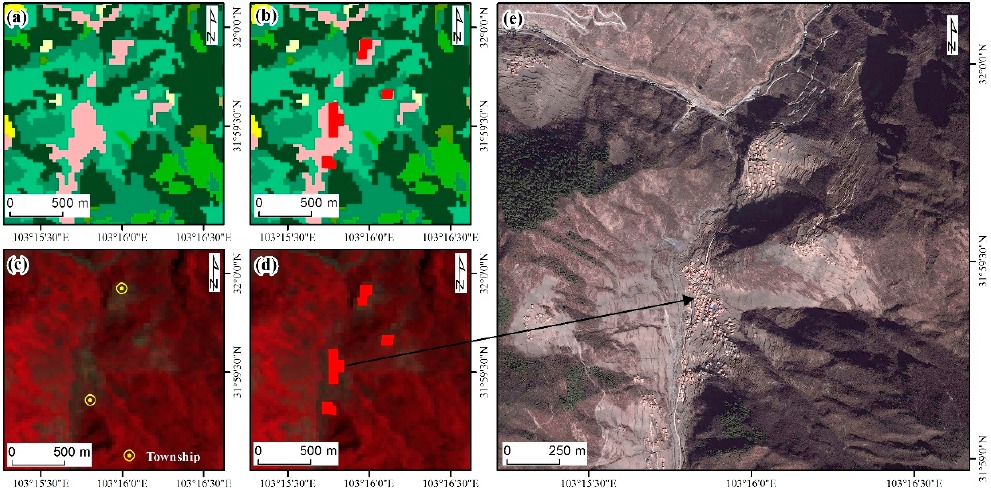
Figure 9. Interactive quality control based on the existing thematic map (township map). ( a ) and ( b ) are the results of unrevised and revised residential lands, respectively; ( c ) is the Landsat TM images and the locations of township; ( d ) is the additional residential lands with the help of the township map and high-resolution satellite images; ( e ) is the high-resolution Google Earth images.